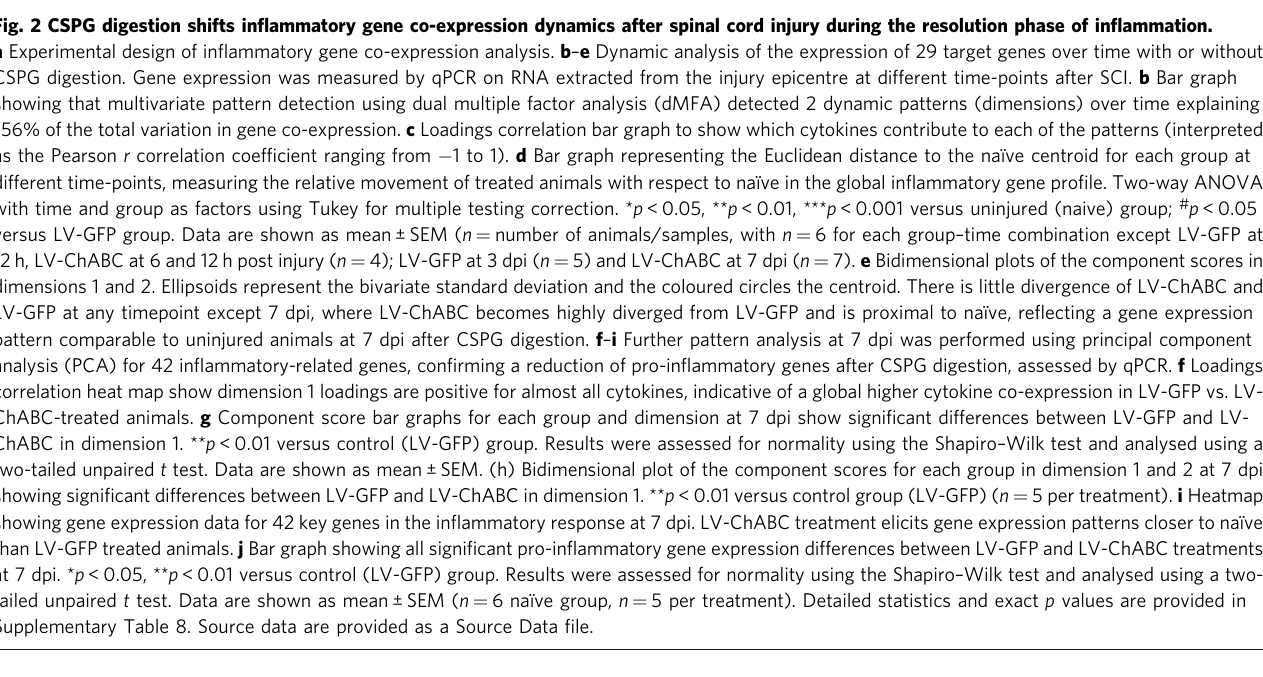
Fig. 2 CSPG digestion shifts in fl ammatory gene co-expression dynamics after spinal cord injury during the resolution phase of in fl ammation. a Experimental design of in fl ammatory gene co-expression analysis. b – e Dynamic analysis of the expression of 29 target genes over time with or without CSPG digestion. Gene expression was measured by qPCR on RNA extracted from the injury epicentre at different time-points after SCI. b Bar graph showing that multivariate pattern detection using dual multiple factor analysis (dMFA) detected 2 dynamic patterns (dimensions) over time explaining ~56% of the total variation in gene co-expression. c Loadings correlation bar graph to show which cytokines contribute to each of the patterns (interpreted as the Pearson r correlation coef fi cient ranging from − 1 to 1). d Bar graph representing the Euclidean distance to the naïve centroid for each group at different time-points, measuring the relative movement of treated animals with respect to naïve in the global in fl ammatory gene pro fi le. Two-way ANOVA with time and group as factors using Tukey for multiple testing correction. * p < 0.05, ** p < 0.01, *** p < 0.001 versus uninjured (naive) group; # p < 0.05 versus LV-GFP group. Data are shown as mean ± SEM ( n = number of animals/samples, with n = 6 for each group – time combination except LV-GFP at 12 h, LV-ChABC at 6 and 12 h post injury ( n = 4); LV-GFP at 3 dpi ( n = 5) and LV-ChABC at 7 dpi ( n = 7). e Bidimensional plots of the component scores in dimensions 1 and 2. Ellipsoids represent the bivariate standard deviation and the coloured circles the centroid. There is little divergence of LV-ChABC and LV-GFP at any timepoint except 7 dpi, where LV-ChABC becomes highly diverged from LV-GFP and is proximal to naïve, re fl ecting a gene expression pattern comparable to uninjured animals at 7 dpi after CSPG digestion. f – i Further pattern analysis at 7 dpi was performed using principal component analysis (PCA) for 42 in fl ammatory-related genes, con fi rming a reduction of pro-in fl ammatory genes after CSPG digestion, assessed by qPCR. f Loadings correlation heat map show dimension 1 loadings are positive for almost all cytokines, indicative of a global higher cytokine co-expression in LV-GFP vs. LV- ChABC-treated animals. g Component score bar graphs for each group and dimension at 7 dpi show signi fi cant differences between LV-GFP and LV- ChABC in dimension 1. ** p < 0.01 versus control (LV-GFP) group. Results were assessed for normality using the Shapiro – Wilk test and analysed using a two-tailed unpaired t test. Data are shown as mean ± SEM. (h) Bidimensional plot of the component scores for each group in dimension 1 and 2 at 7 dpi showing signi fi cant differences between LV-GFP and LV-ChABC in dimension 1. ** p < 0.01 versus control group (LV-GFP) ( n = 5 per treatment). i Heatmap showing gene expression data for 42 key genes in the in fl ammatory response at 7 dpi. LV-ChABC treatment elicits gene expression patterns closer to naïve than LV-GFP treated animals. j Bar graph showing all signi fi cant pro-in fl ammatory gene expression differences between LV-GFP and LV-ChABC treatments at 7 dpi. * p < 0.05, ** p < 0.01 versus control (LV-GFP) group. Results were assessed for normality using the Shapiro – Wilk test and analysed using a two- tailed unpaired t test. Data are shown as mean ± SEM ( n = 6 naïve group, n = 5 per treatment). Detailed statistics and exact p values are provided in Supplementary Table 8. Source data are provided as a Source Data fi